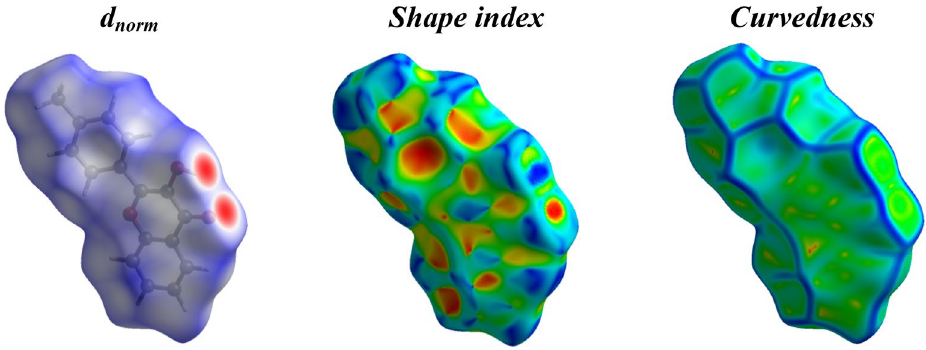
Figure 13. Hirshfeld surfaces (d norm , shape index, and curvedness) of compound 12